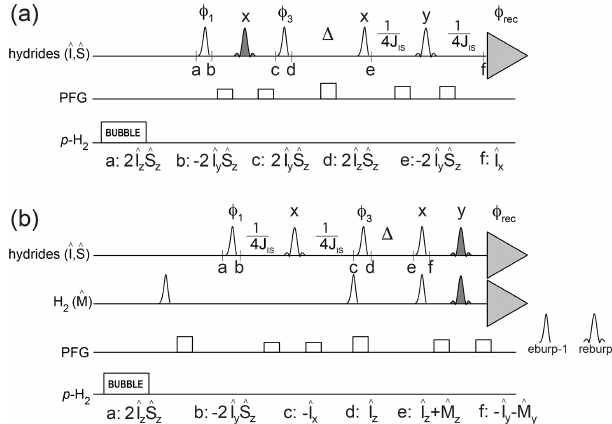
Figure 2. Pulse sequences to measure relaxation and kinetic param- eters for hydrides in asymmetric complexes. The transmitter offset is placed at − 11.35ppm, and the spectral region between − 31.36 and 8.66ppm is acquired. Open-shaped profiles indicate selective off-resonance pulses eburp-1 (for excitation of the high-field hy- dride, 500Hz bandwidth) or reburp (for refocusing, 2000Hz band- width). Filled reburp pulses cover a smaller bandwidth (500Hz) for the hydrogen and/or the high-field hydride resonance. Individ- ual scans are stored separately and recombined during process- ing so that different pathways can be selected. J IS indicates the inter-hydride scalar coupling constant (8.2Hz). (a) Pulse scheme to measure the decay rate of hydrides’ longitudinal spin order as well as association of p-H 2 with the iridium complex. The fol- lowing phase cycle is employed: ϕ 1 = x, − x ; ϕ 3 = x,x, − x, − x ; ϕ rec = x . (b) Pulse scheme to measure the decay rate of hydrides’ longitudinal magnetization as well as hydride dissociation from the complex. The following phase cycle is employed: ϕ 1 = x, − x ; ϕ 3 = y,y, − y, − y ; ϕ rec = x, − x, − x,x . H 2 longitudinal magneti- zation is suppressed at the start of the pulse sequence by selec- tive 90 ◦ pulses after the bubbling period and at the beginning of the relaxation period (cid:49) . The final excitation/spin echo before ac- quisition selectively excites/refocuses both the magnetization from H 2 and from the high-field hydride. In other words, the last exci- tation/refocusing pulses consist of the superposition of two eburp- 1 / reburp pulses, for the selective detection of the high-field hydride as well as the hydrogen